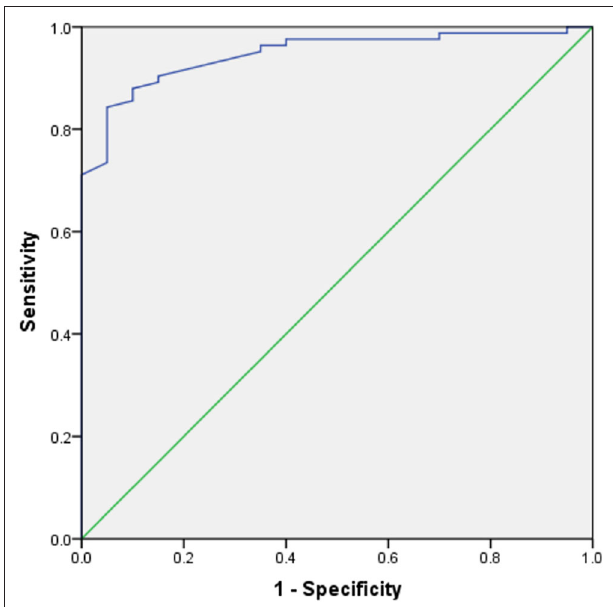
FIGURE 1 | ROC curves for the prediction of DN using serum Zn concentration.